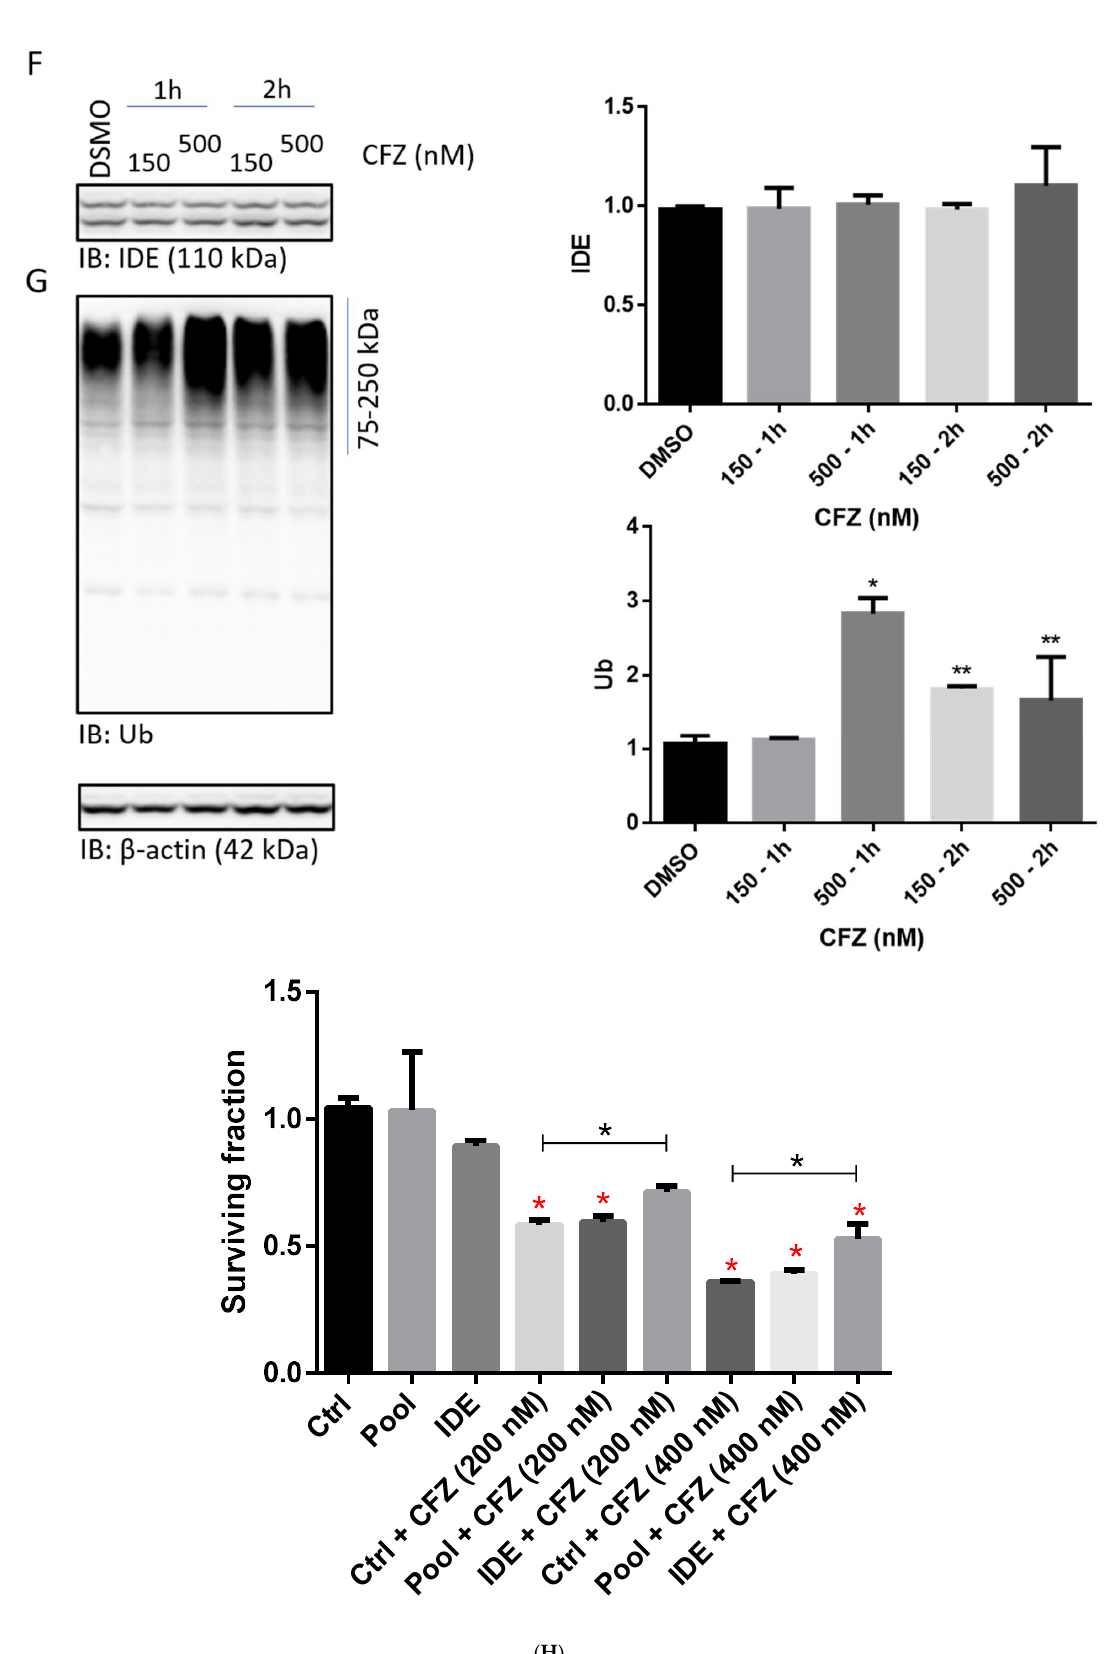
Figure 5. ( A ) Proteasome assemblies were separated by mass/charge under non-denaturing condi- tions and probed with 50 µM LLVY-amc; ( B ) Upon blotting, filters were cut and capped assemblies and free 19S and 20S were stained by using an anti-Rpt5 antibody and an anti-α7 antibody, respec- tively. Intensity of Rpt5 immunostaining of single-capped proteasome was quantified (* p < 0.0001); ( C ) uneven gel loading was ruled out by Ponceau staining of filter and by probing the cell extracts for α7 under denaturing and reducing conditions; ( D ) Immunostaining of IDE dimer and IDE asso- ciated with the single-capped proteasome. Intensity was calculated (* p < 0.0002; ** p < 0.0001); ( E ) immunostaining of HSP70 associated with proteasome assemblies; ( F ) semiquantitative analysis of IDE and of poly-ubiquitinated proteins ( G ) under denaturing and reducing conditions (* p < 0.004; ** p < 0.0001). ( H ) rMC1 were challenged with 50 nM IDE siRNA (IDE-siRNA), a pool of non-target- ing oligonucleotides (Pool) or oligonucleotides vehicle (Ctrl). After 48 h, cells were exposed to 200 nM and 400 nM CFZ or to an equivalent volume of DMSO (CFZ vehicle). Cytotoxicity was assayed 24 h after treatment with CFZ (i.e., 72 h after siRNA addition) by MTS assay. Data summarized in histograms refer to normalized O.D. at 470 nm (reference 630 nm) for each experimental condition. Red and black asterisks refer to intra-group and inter-group comparisons, respectively. Data pre- sented are mean ± SD ( n = 3). A representative experiment of three independent observation is re- ported. Statistical analysis was performed by one-way ANOVA followed by Tukey’s post-hoc sig- nificance test. * p < 0.001. As expected, IDE immunostaining under denaturing and reducing conditions was fully comparable under all tested experimental conditions (Figure 5F), and poly-ubiqui- tinated proteins accumulated with the exception of cells treated with 150 nM CFZ for 1 h (Figure 5G). These features indeed suggest that (i) proteasome inhibition by CFZ likely leads to a faster degradation of all proteasome populations, and (ii) interaction with CFZ brings about an enhancement of IDE affinity for single capped proteasome particles, likely cou- pled to the CFZ-linked conformational change (see Figure 1). Therefore, rMC1 cells were preliminary silenced for IDE expression by delivery of anti-sense oligonucleotides (siRNA) at 50, 75 and 100 nM final concentration. As internal controls, rMC1 cells were challenged with the siRNA vehicle (generally referred to as